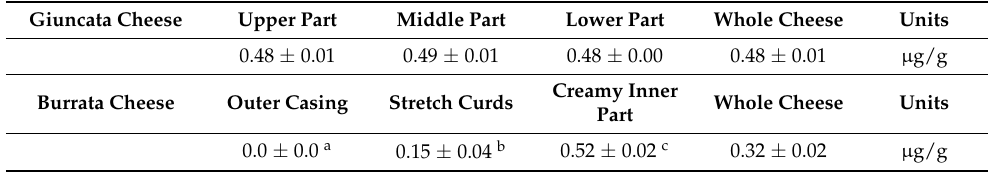
Table 3. Distribution of vitamin D 3 into cheese